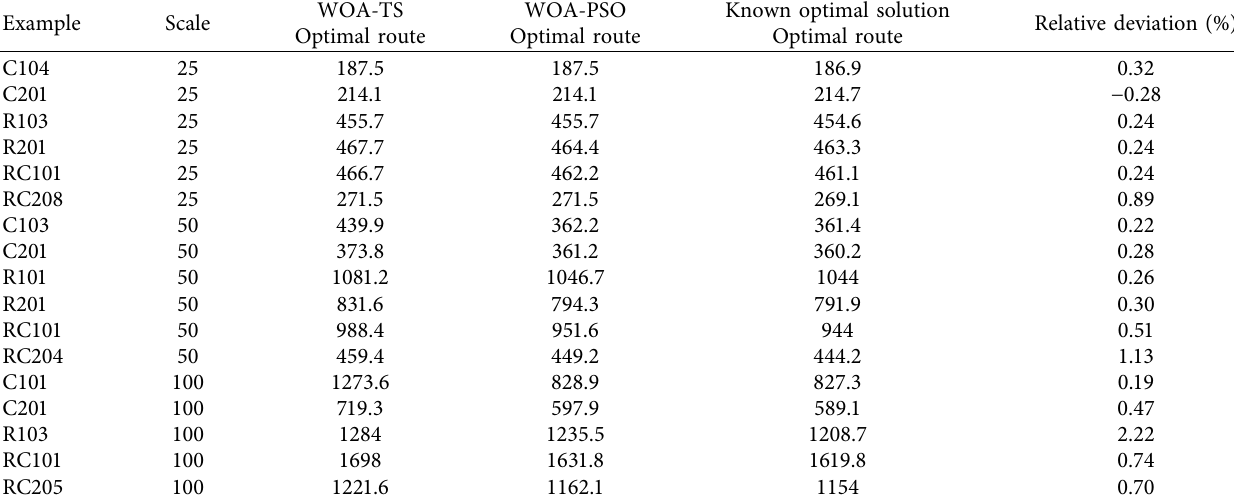
Table 4: Comparison between the WOA-PSO algorithm and existing algorithms.